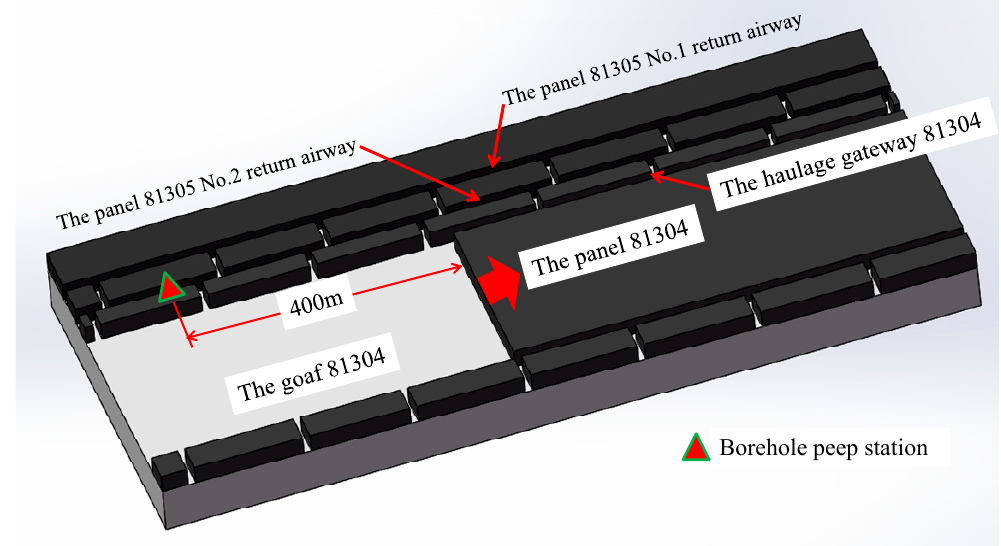
Figure 3. Three-roadway arrangement in the panel of Baode coal mine.